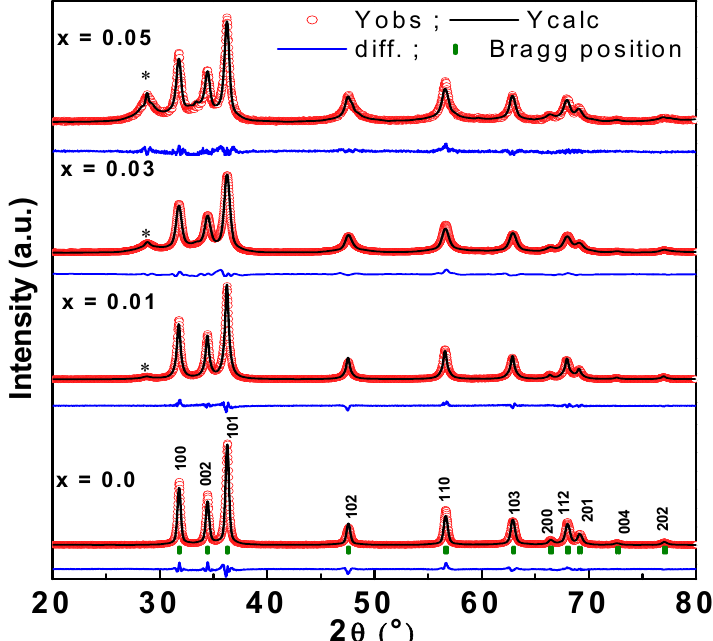
Figure 4. XRD patterns of Yb and Ce co-doped ZnO NPs where ‘*’ indicates the peaks belonging to a secondary phase.